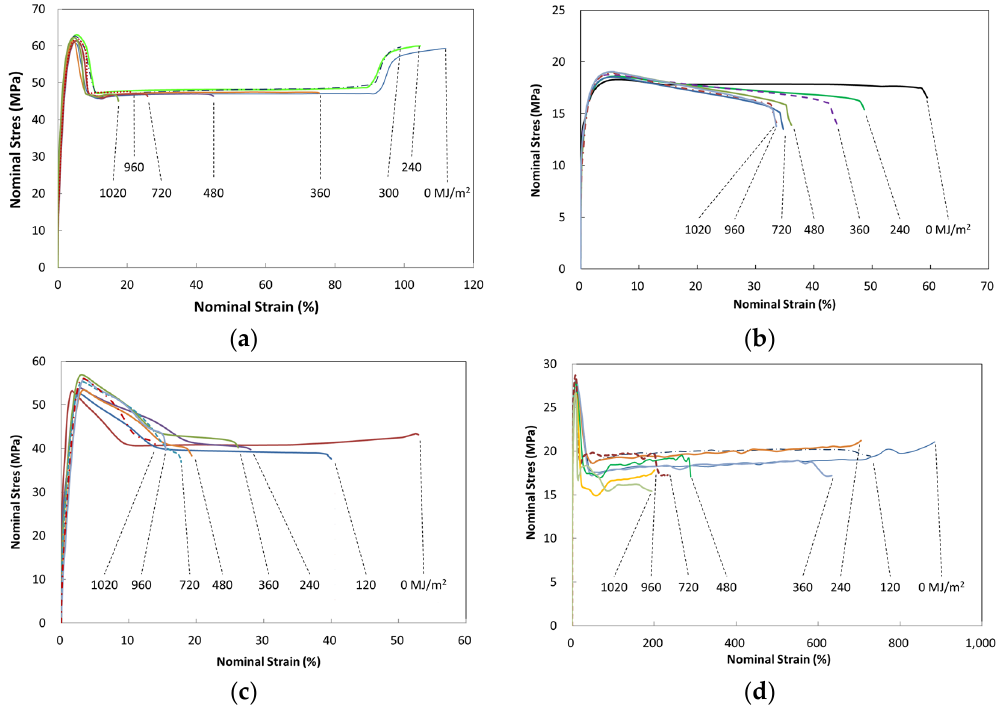
Figure 7. Nominal tensile stress–strain curves of weather-exposed polymers during a 4-year weathering test: ( a ) PC; ( b ) PP; ( c ) PBT; and ( d ) HDPE.